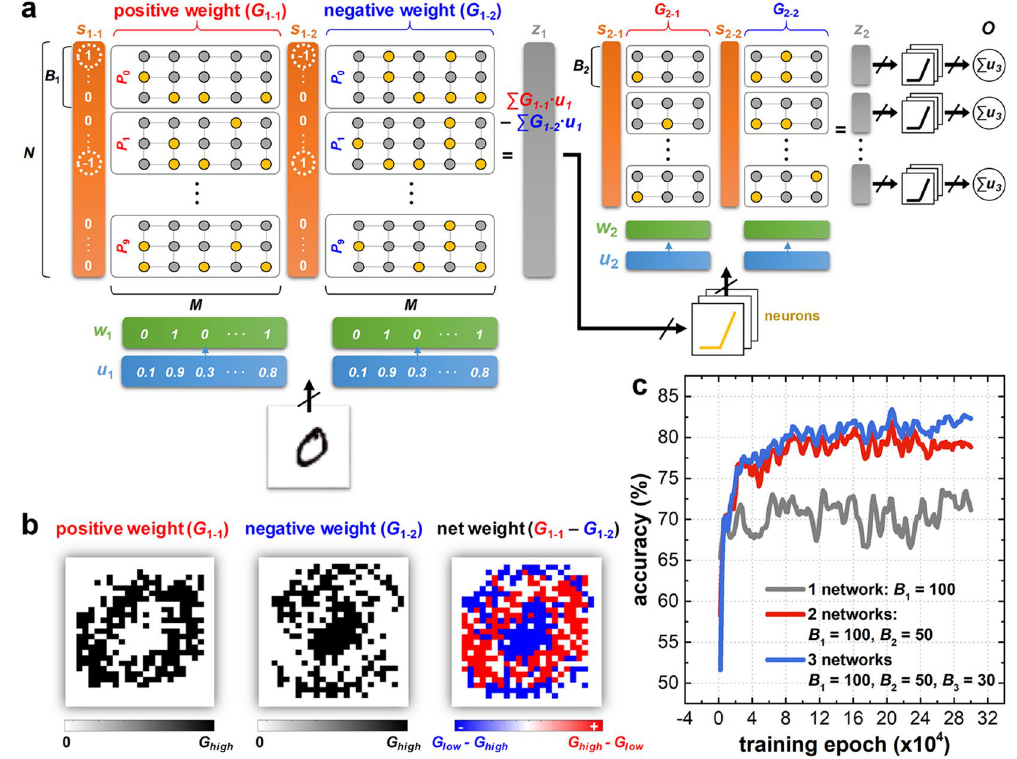
Figure 3. ( a ) Schematic of the network architecture for handwritten digit classification with two networks ( G 1 and G 2 ). Each network is divided into two subnetworks ( e . g ., G 1-1 and G 1-2 ) to represent positive and negative synaptic weights, respectively. This subnetwork is partitioned again to the buckets ( P 0 ~ P 9 ), where each bucket is trained on the input patterns according to the label. ( b ) One example of synaptic weights after 60000 times of the training epoch: one row at the bucket P 0 is selected from G 1-1 and G 1-2 , and the resultant G 1-1 – G 1-2 are plotted, respectively. ( c ) The evolution of classification accuracy as a function of the training epoch, which is also affected by the network configuration ( i . e ., number of networks, bucket size, learning rate). The learning rate γ of all results is